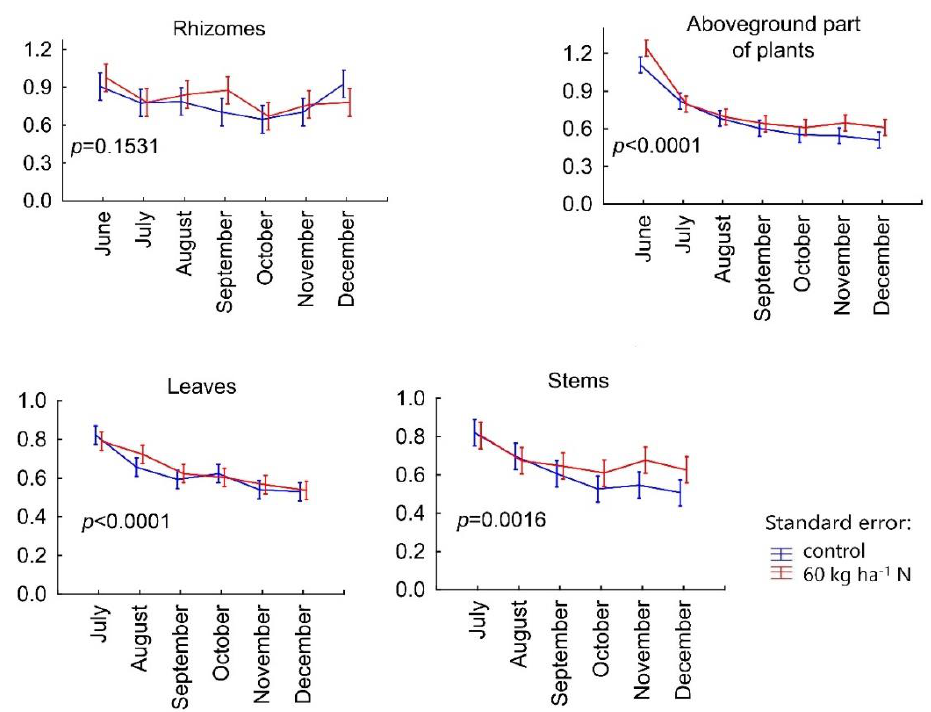
Figure 8. Sulphur content in examined part of miscanthus (g kg − 1 ) (three-year average content from measurements during the growing season every 30 days).